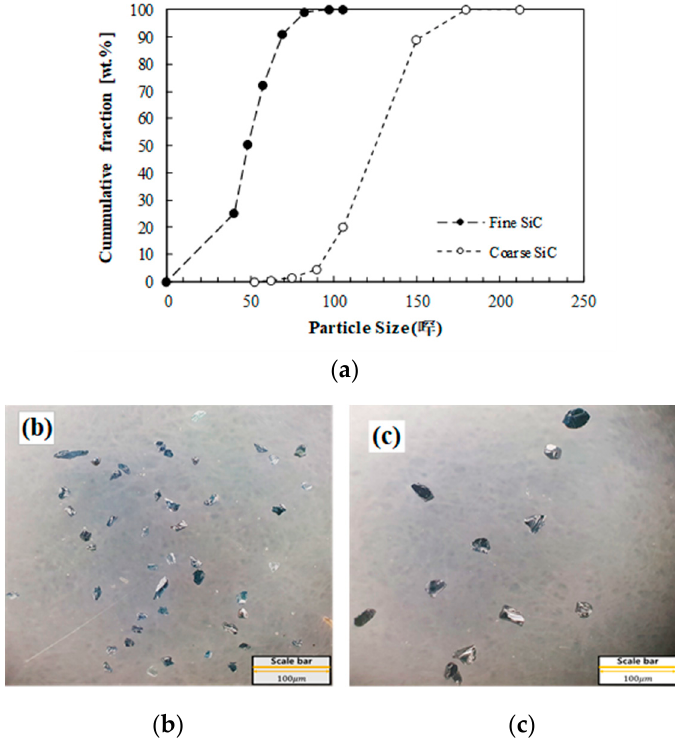
Figure 2. ( a ) Particle size distributions of SiC particles, Magnified images of ( b ) fine SiC particles and ( c ) coarse SiC particles.